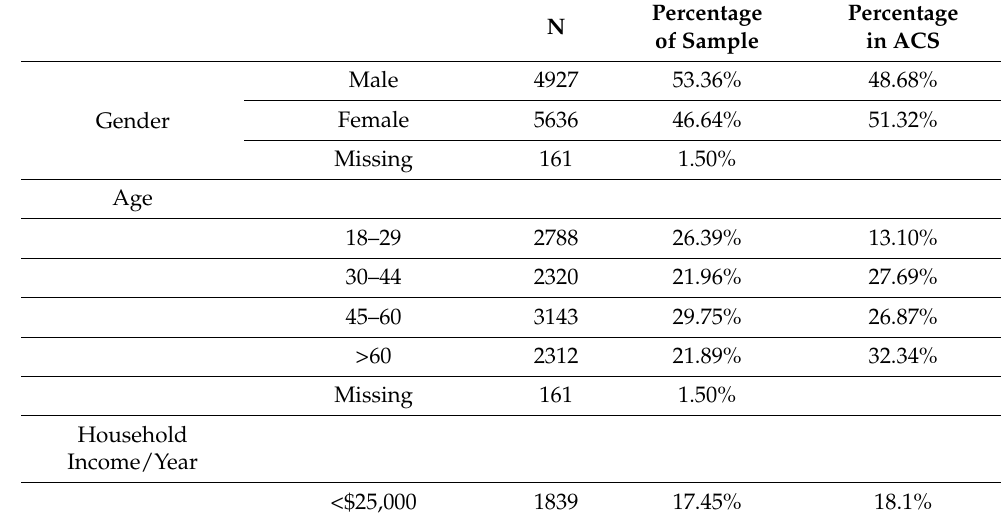
Table 2. Sample demographics (N = 10,724) Compared to the American Community